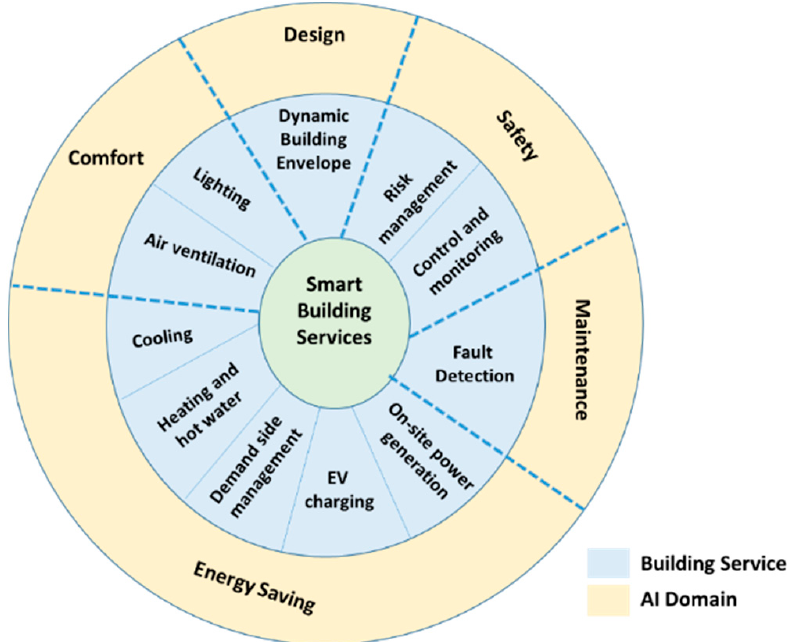
Figure 5. Smart building services and domains categories in this study.